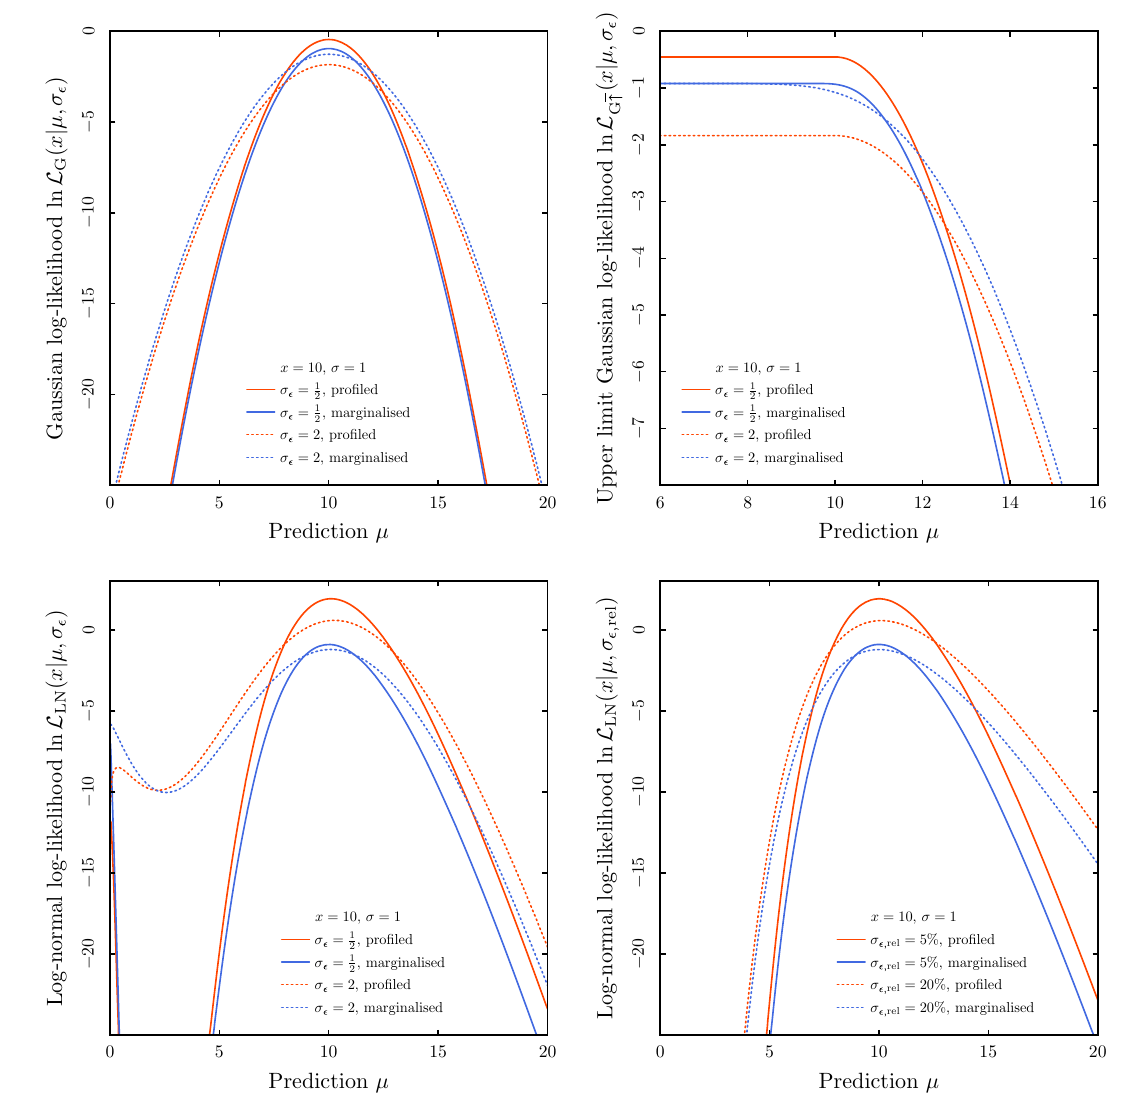
central value of x = 10 and standard deviation σ = 1, for two different assumed values of the systematic error. Two potential pitfalls are visi- ble: the profiled upper limit likelihood shows a strong dependence on σ (cid:11) at low values of μ , and adopting an absolute systematic uncertainty can introduce additional features in the log-normal likelihood at low